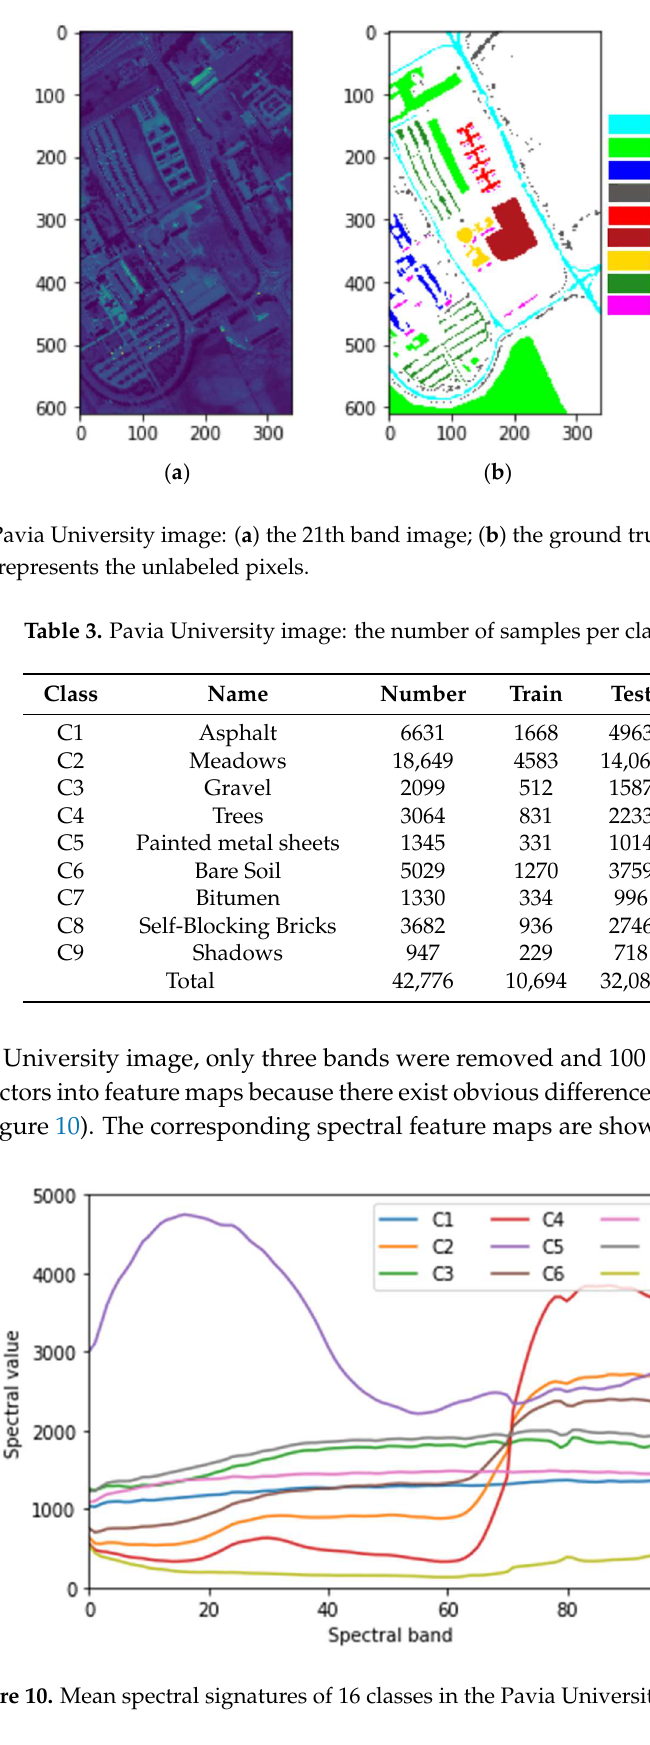
Figure 10. Mean spectral signatures of 16 classes in the Pavia University dataset.